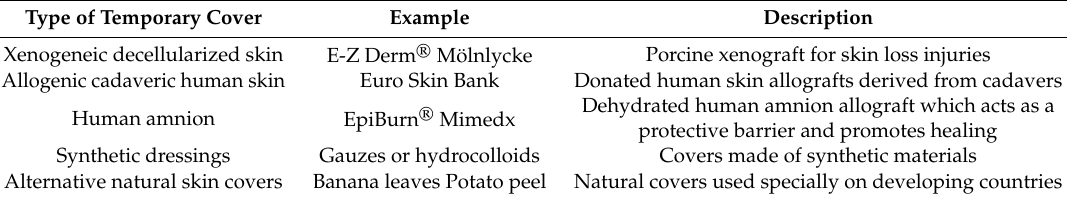
Table 1. Classification of temporary skin substitutes 1